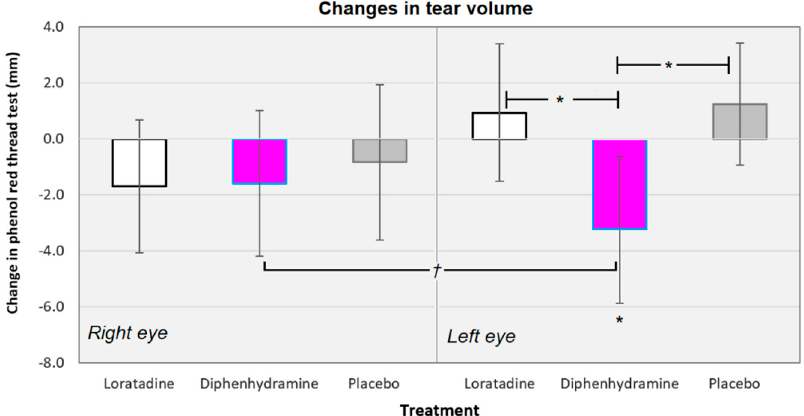
Figure 1. Changes in the tear volume averaged across all the subjects for the right and left eyes, separately. There were no significant differences between treatments for the right eye, but diphenhydramine significantly reduced the tear volume in the left eye. There was a trend for diphenhydramine use to reduce the tear volume when averaged for the right and left eyes ( p = 0.072). Diphenhydramine also reduced the tear volume in the left eye more than the placebo and loratadine. * p < 0.05, † p < 0.10; Error bars represent ±95% confidence intervals.